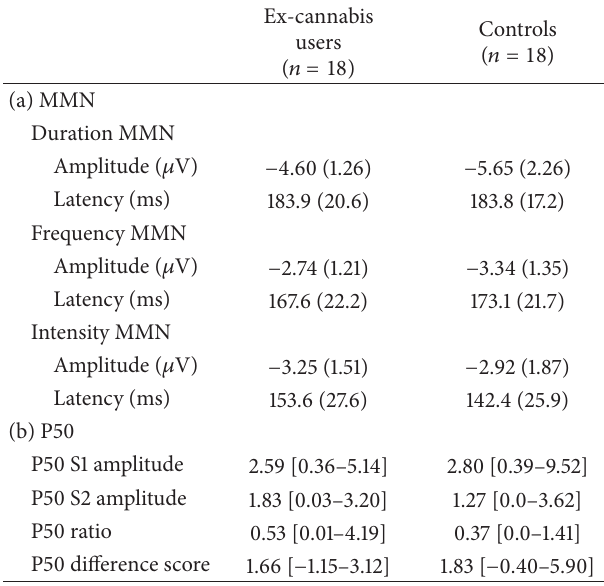
Table 3: (a) Mean (SD) MMN amplitude ( 𝜇 V) and latency (ms) at Fz and (b) median [range] P50 metrics ( 𝜇 V) at Cz for ex-cannabis users and healthy nonuser